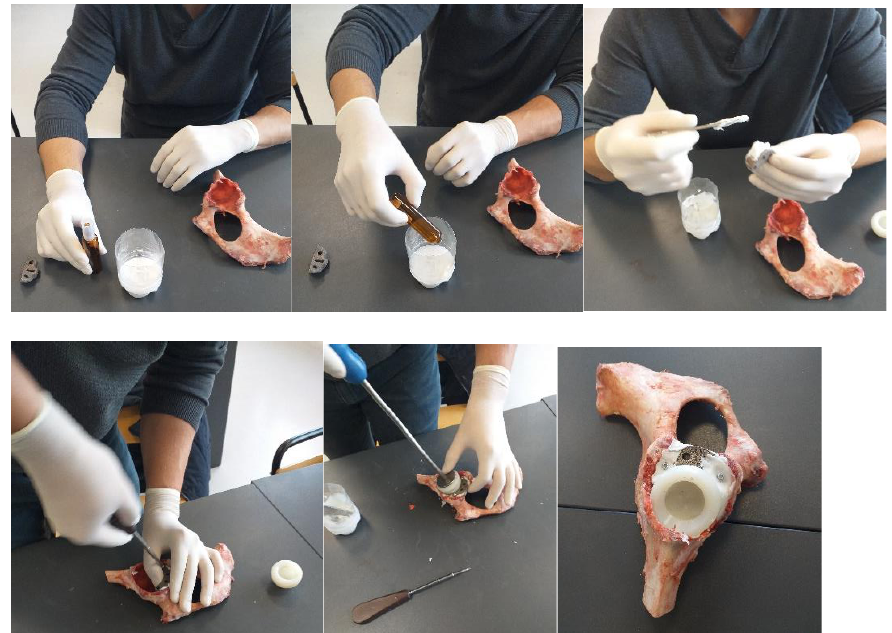
Figure 5. Steps for fixation of prosthesis elements using orthopaedic cement.